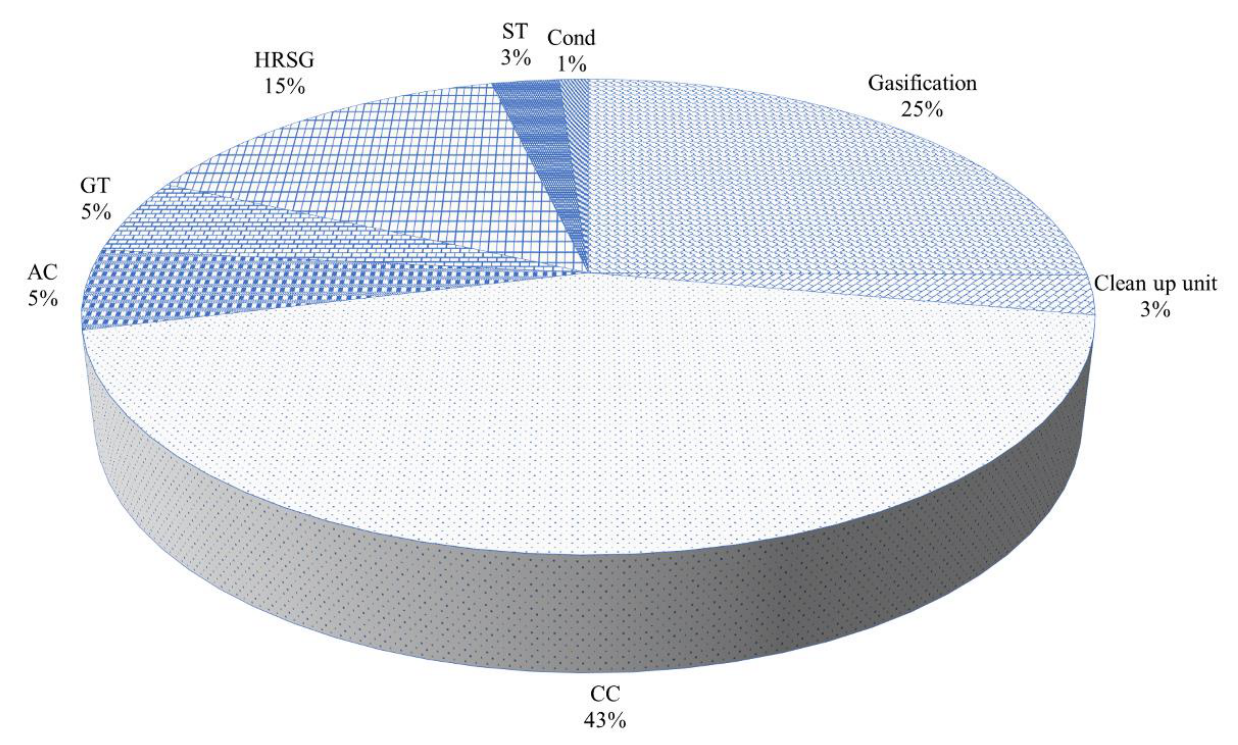
Figure 2. Share of exergy destruction for the different ISGC system components. AC: Air compressor; Cond: Condenser; CC: Combustion chamber; GT: Gas turbine; HRSG: heat recovery steam generator; ST: steam turbine.